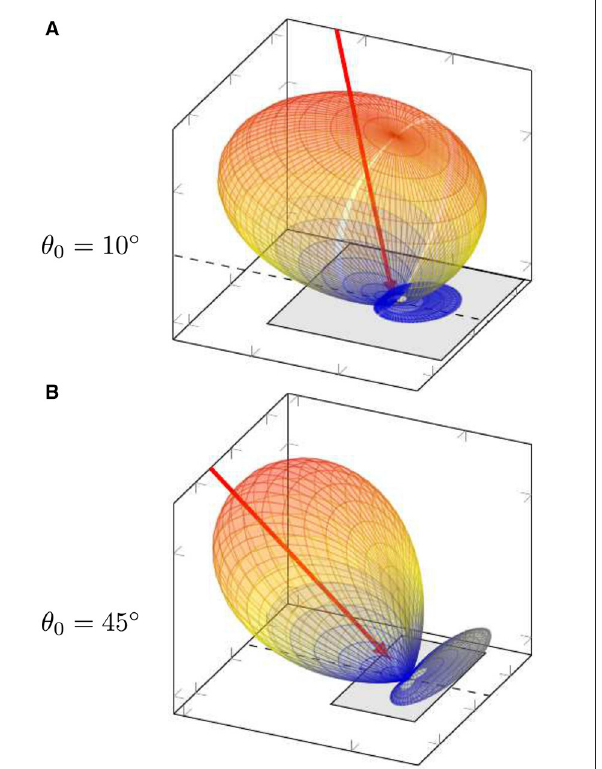
FIGURE 4 | Elastic backscattering lobes for an electron beam (red arrow) of energy E 0 = 40 eV incident on an aluminum surface at two different angles (A) θ 0 = 10 ◦ and (B) θ 0 = 45 ◦ . Adapted from Villemant et al. [110] with permission of the copyright